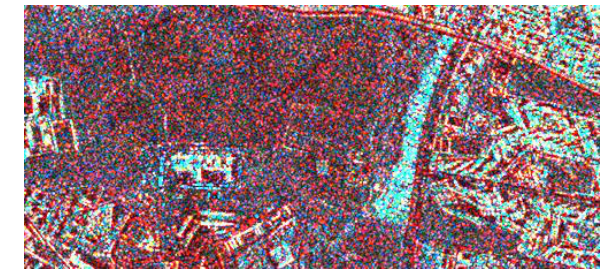
Figure 16. RGB Coherence between two SAR images (August-